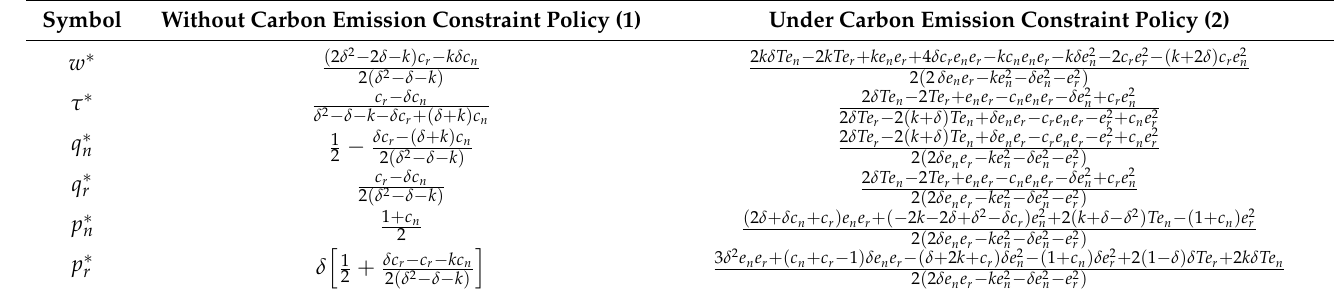
Table 2. Optimal solutions under the two